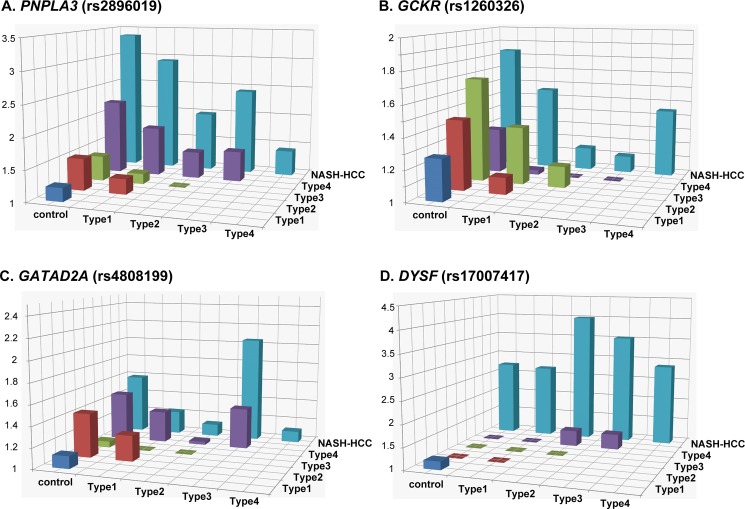
Histogram of the odds ratios for genotype distributions between different subgroups.Each box denotes the odds ratio (OR) comparing the control or patient subgroups shown on the horizontal axes. The p-values, ORs, and 95% confidence intervals are shown in the S6 Table.